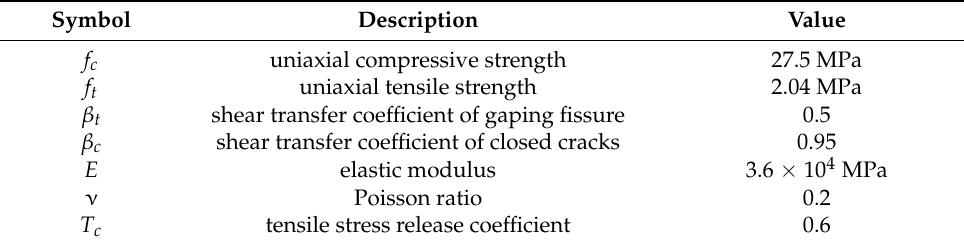
Table 1. Mechanical parameters of C60 concrete.